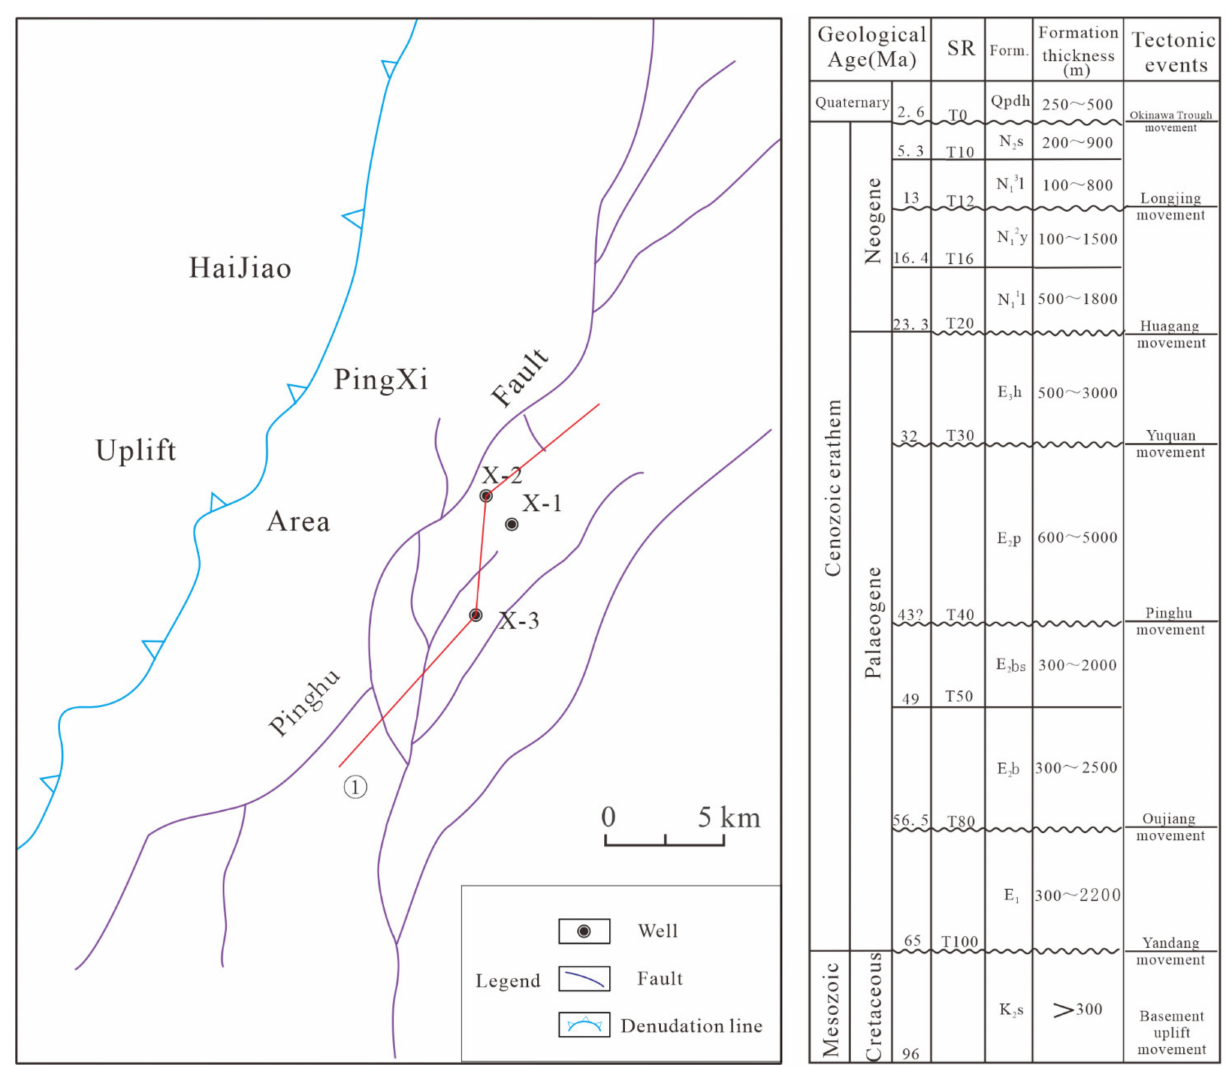
Figure 1. Primary geological structures and the regional stratigraphy in the study area. Locations of wells and seismic profiles in Figure 9 are